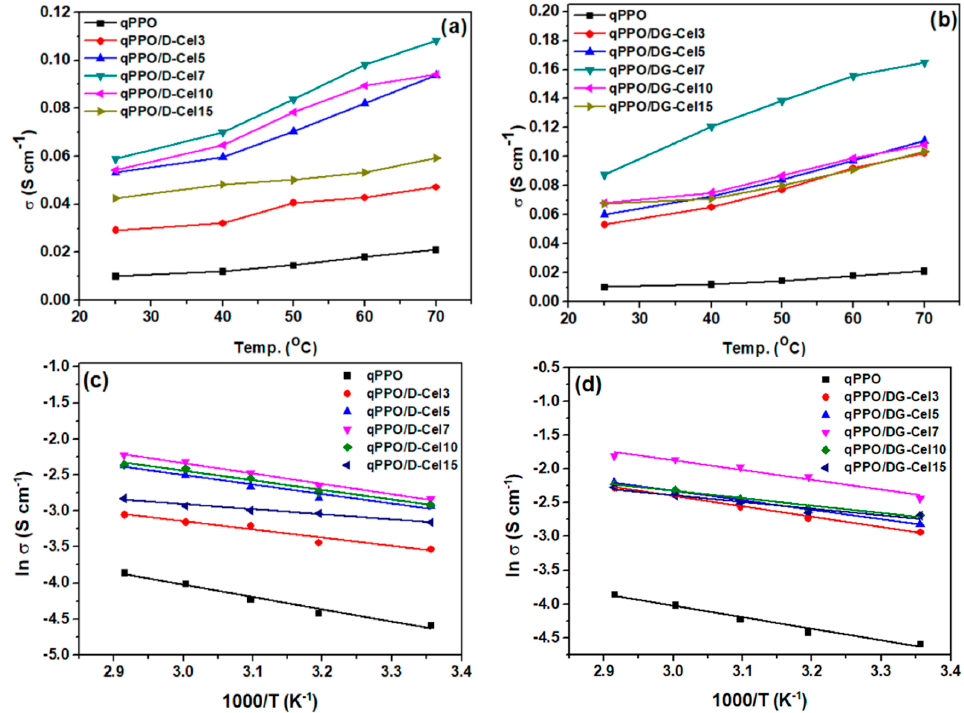
Figure 4. Ionic conductivity vs. temperature of ( a ) qPPO/D-Cel and ( b ) qPPO/DG-Cel membranes and Arrhenius plot of ( c ) qPPO/D-Cel and ( d ) qPPO/DG-Cel membranes.